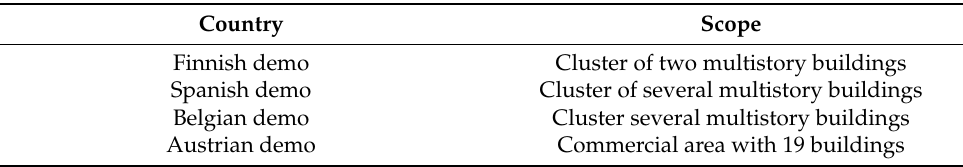
Table 3. Overview of the spatial scope of the EXCESS